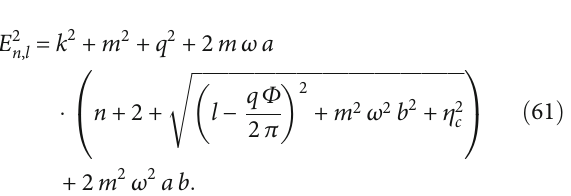
= 1 , α = 0 : 5 , ω = 0 : 5 , Φ = π c